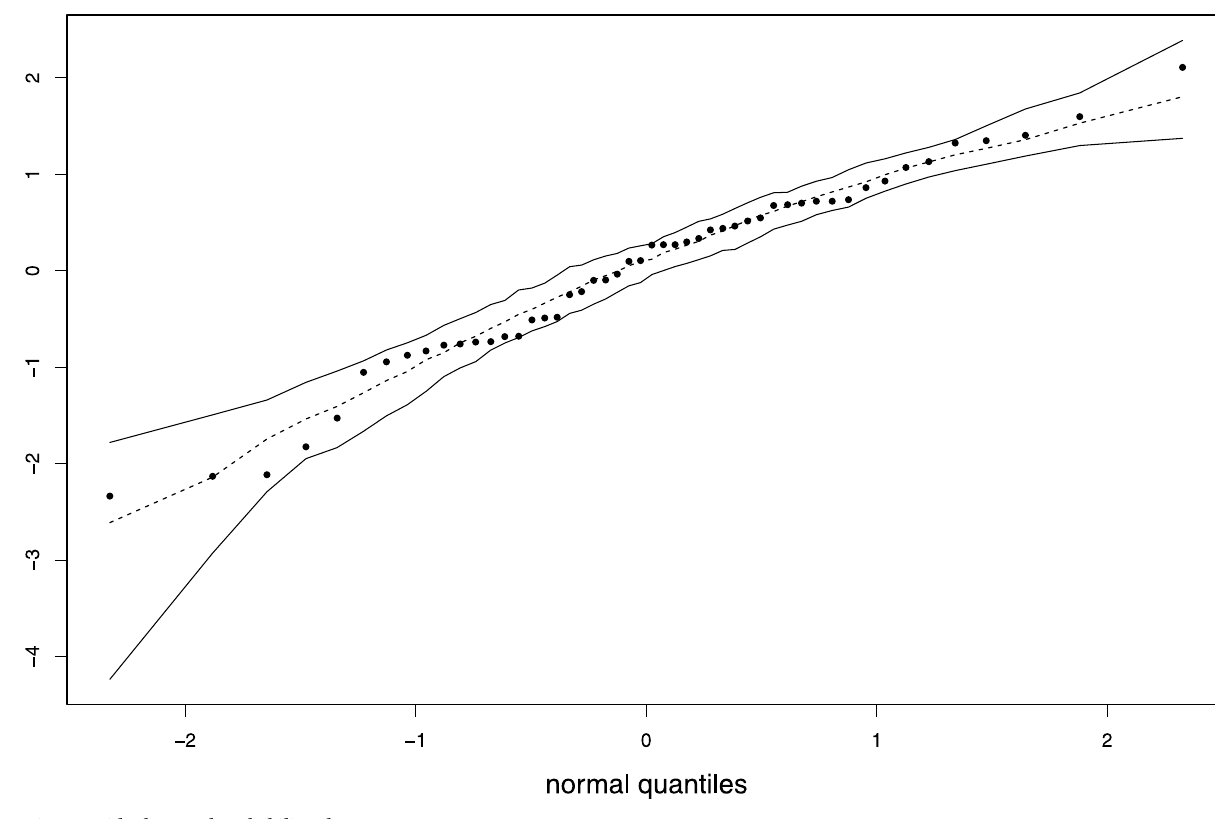
Fig 3. Residual normal probability